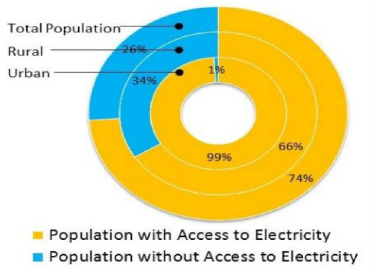
Figure 3: Electric Energy Access